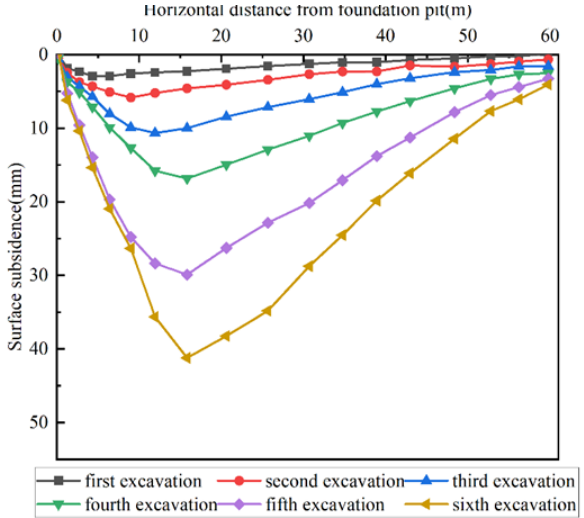
Figure 24. Surface settlement curve during foundation pit excavation with a 0.005 m-wide seepage point.